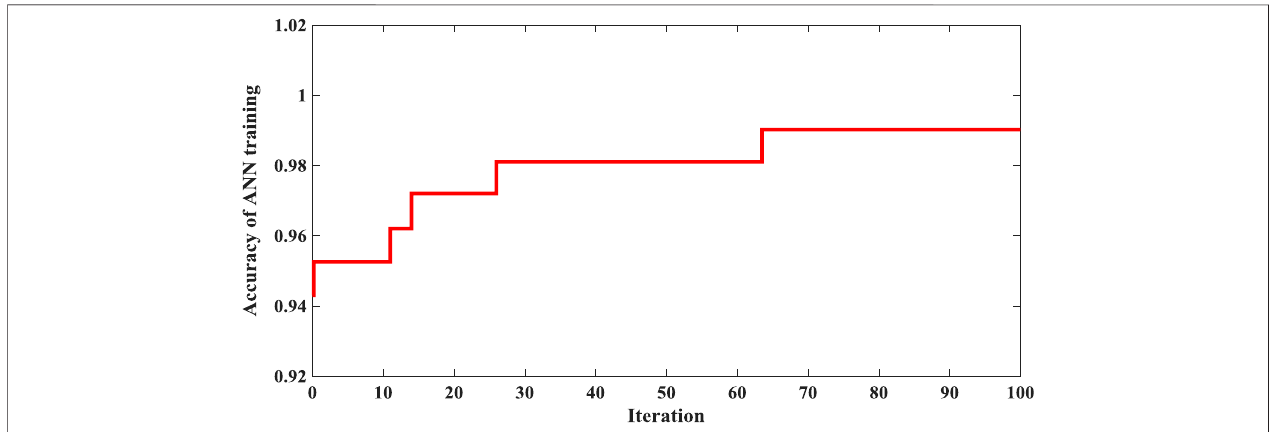
FIGURE 6 | Convergence curve of the ANN accuracy during the GWA-tuning